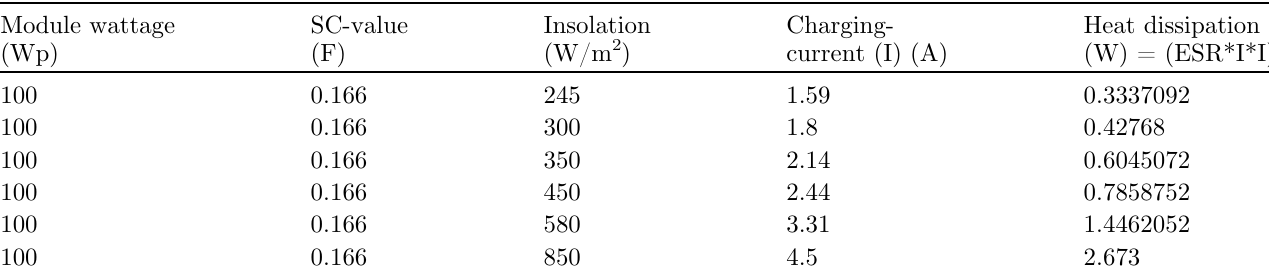
Table 2. Heat dissipation when 100 Wp PV modules use supercapacitor loading.